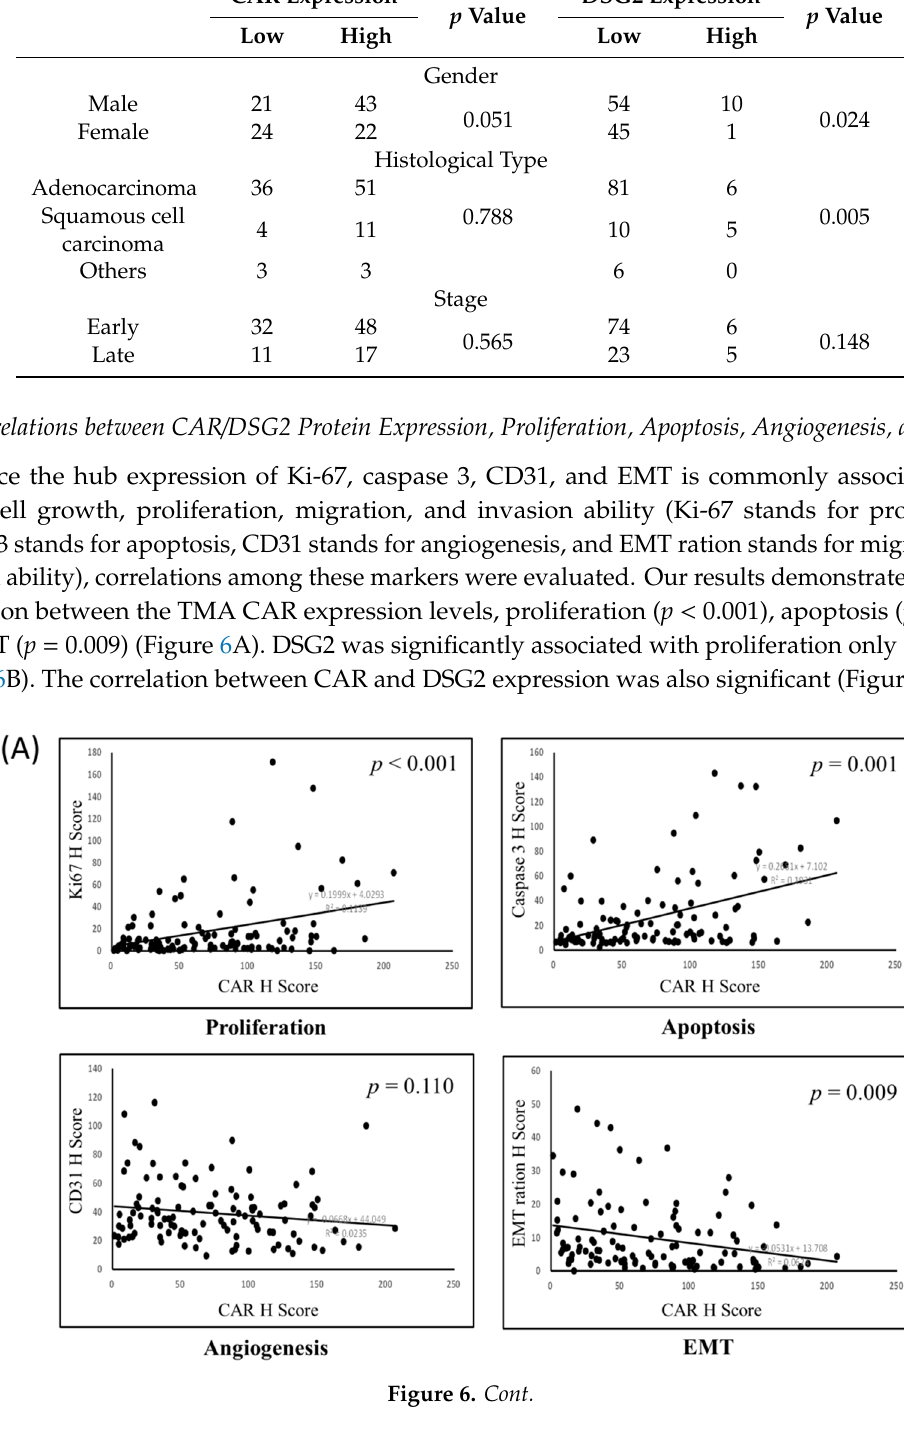
Figure 6. Bi-variant correlation for ( A ) proliferation, apoptosis, angiogenesis, and epithelial– mesenchymal transition (EMT) with CAR; ( B ) proliferation, apoptosis, angiogenesis, and EMT with DSG2; and ( C ) the correlation of CAR with DSG2.